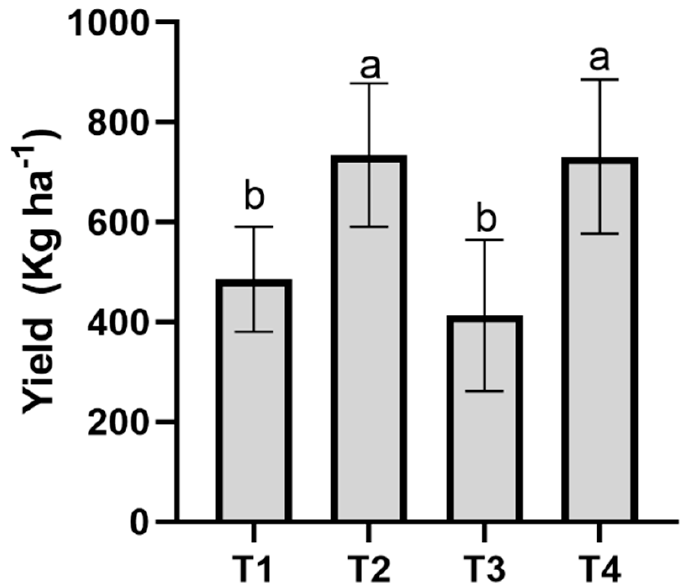
Figure 1. Cumulative yield in spears from the four different plots: untreated control (T1), Brassica pellets (T2), chicken manure pellets (T3), and Dazomet (T4). Values are expressed as means ± standard error ( n = 4). Bars marked with different letters indicate significant differences among genotypes based on the LSD 0.05 test ( p < 0.05).